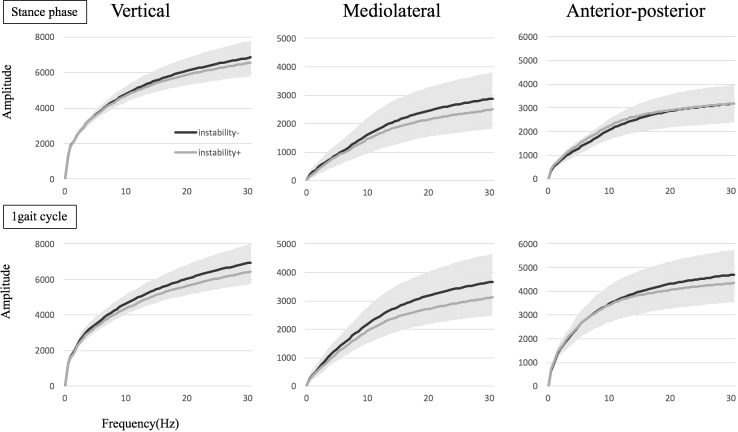
The cumulative amplitude in the frequency < 30 Hz in the fast Fourier transform (FFT) between the groups with or without subjective instability is shown.The colored range means standard deviation (SD) in all groups.